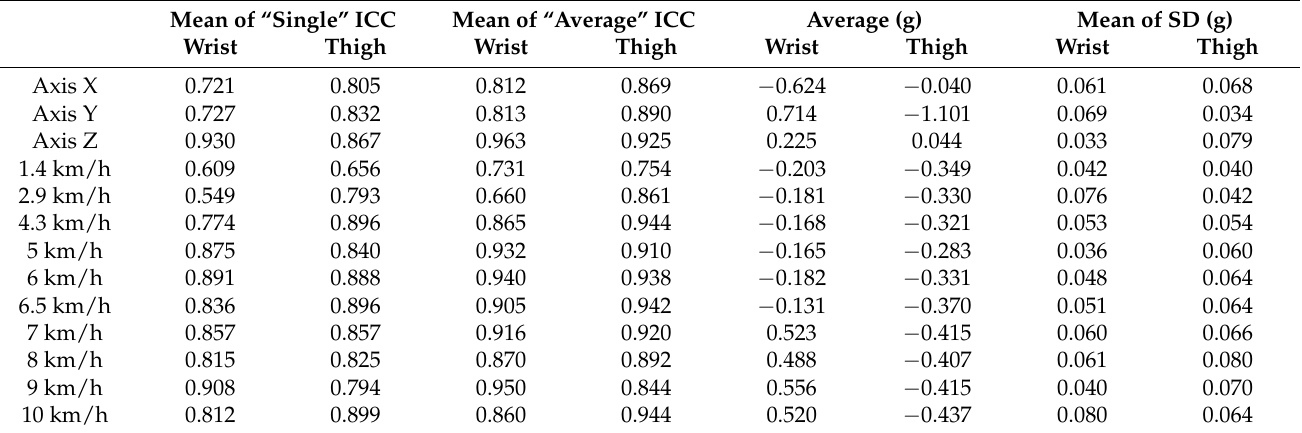
Table 3. Mean of ICC values for “single measurements” option, “average measurements” option, an average of the signal and standard deviation (SD), for each axis and velocity in each position, wrist and